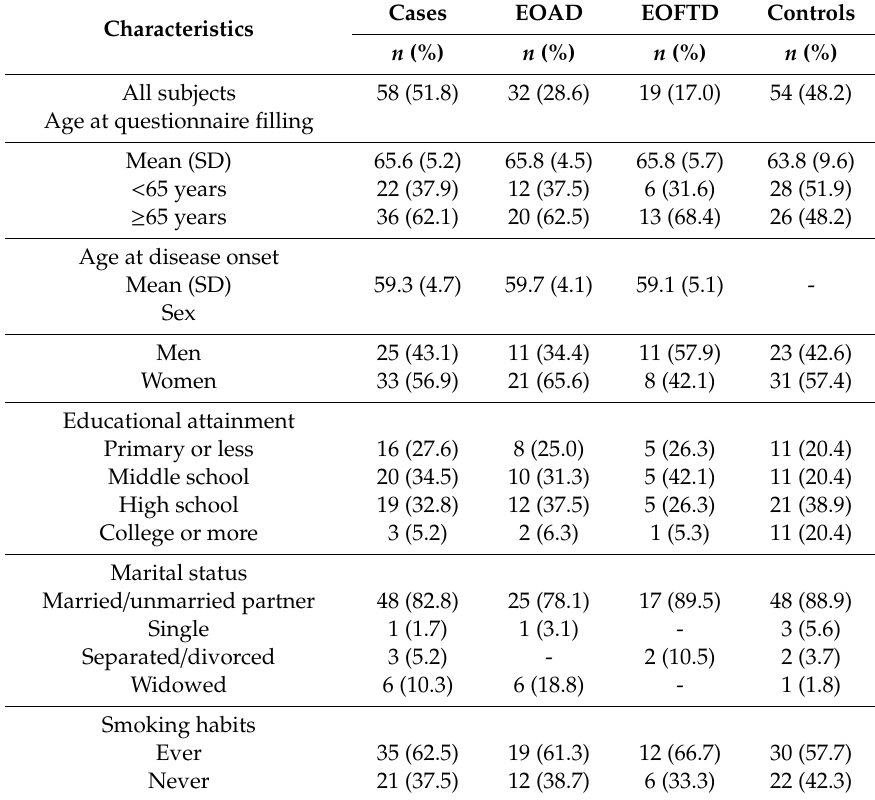
Table 2. Sociodemographic characteristics of early-onset dementia cases (EOAD, early-onset Alzheimer’s dementia; EOFTD, early-onset frontotemporal dementia) and controls.